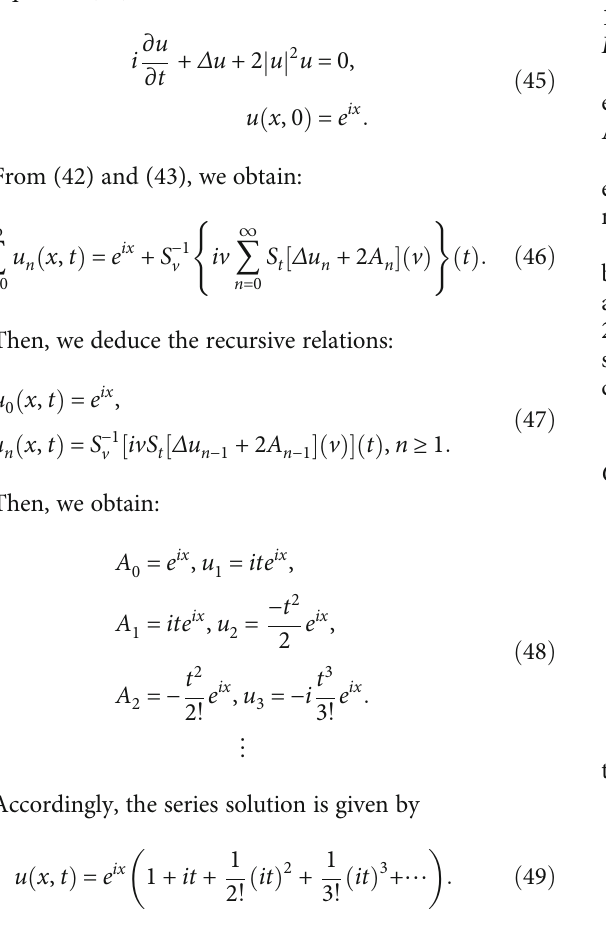
The algorithm is coded by the symbolic computation software